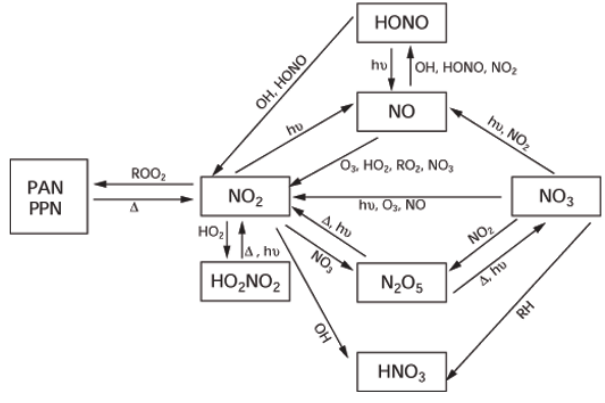
Fig. 7. Illustration of the interaction between the various nitrogen oxide (NO y ) compounds in the tropospheric boundary layer. The symbol 1 represents energy leading to thermal degradation, h ν so- lar radiation leading to photo dissociation and RH a hydrocarbon reacting with the species in question. PPN is a notation for other peroxy nitrates than PAN. Source (Derwent and Hertel,